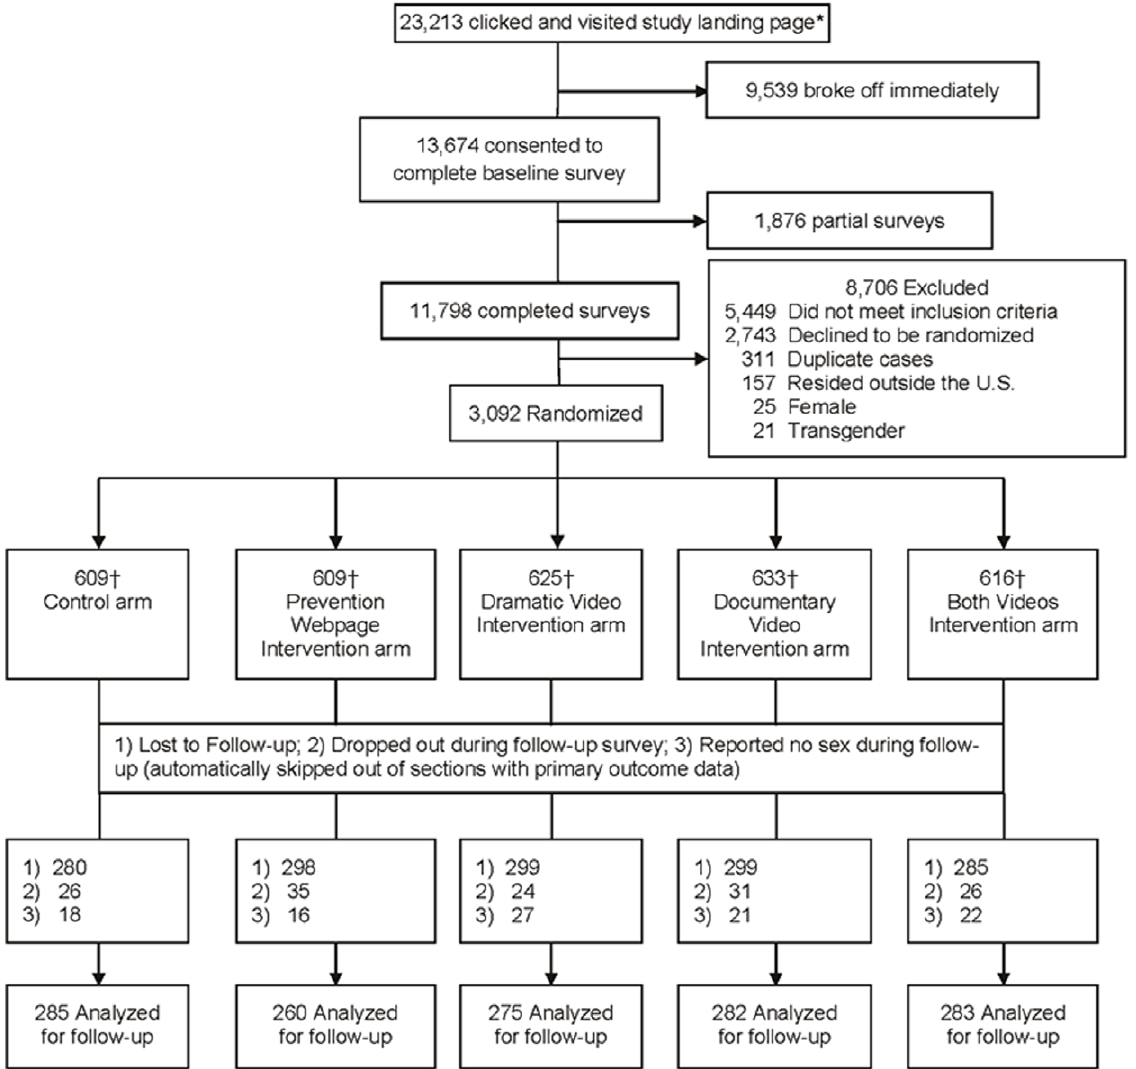
Figure 1. Study flow chart. *Recruited via email (n=609,960) or banner ad (the number of impressions that men were exposed to are not available). { Completed baseline behavioral survey.